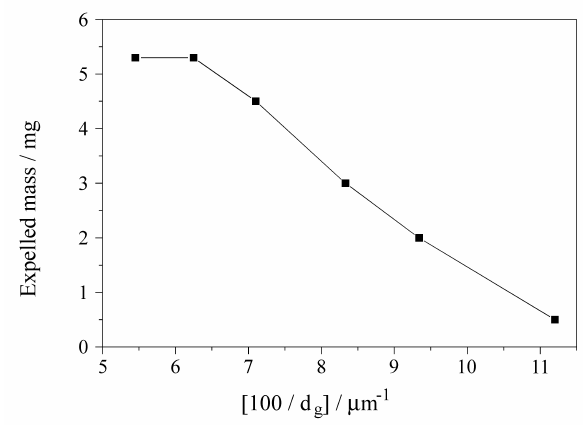
Figure 8. Dependence between the expelled glass mass and grain